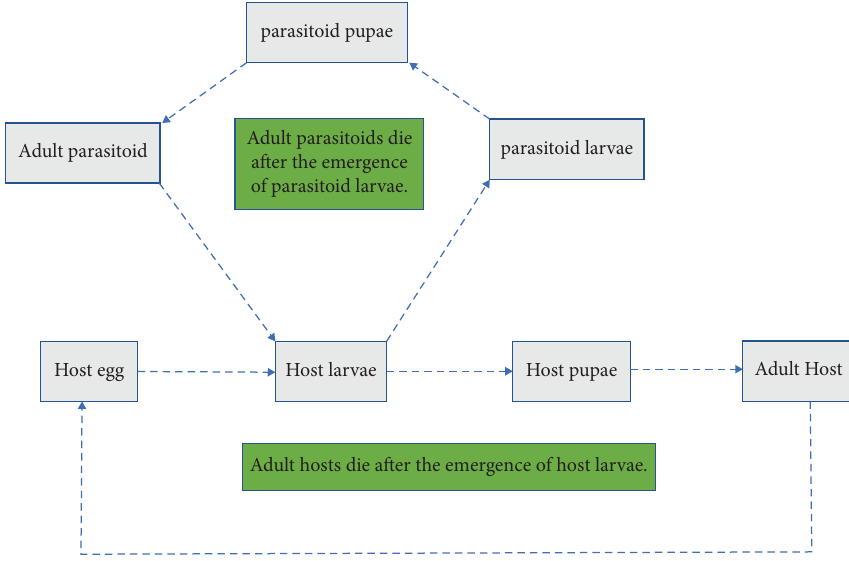
Figure 1: Host and parasitoid life